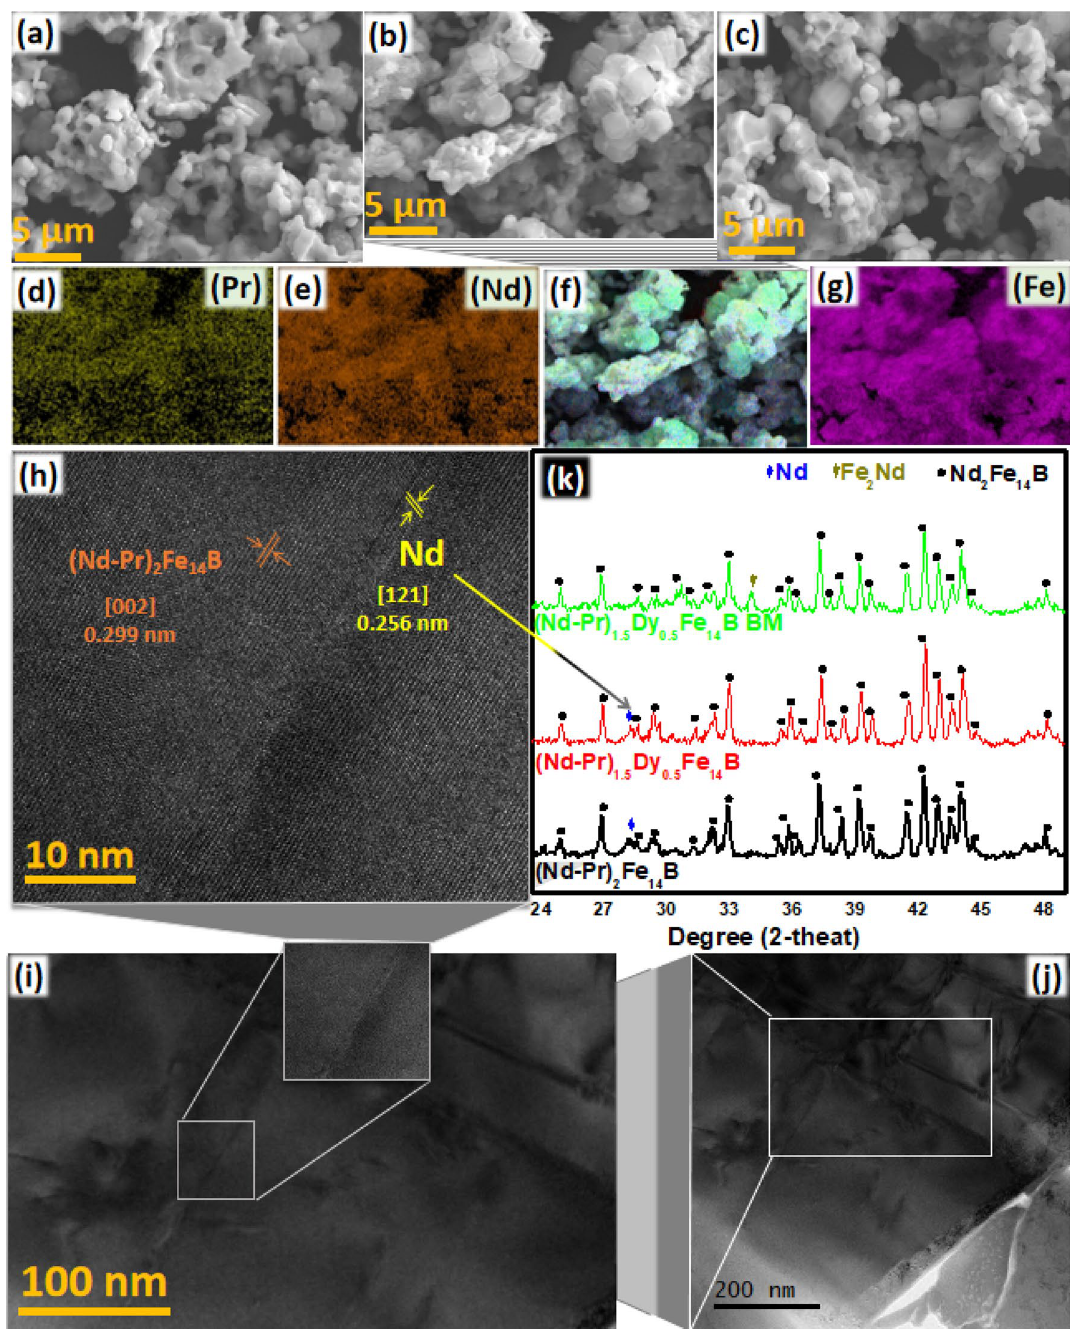
Figure 3. SEM images of ( a ) (Nd–Pr) 1.5 Dy 0.5 Fe 14 B (b) (Nd–Pr) 2 Fe 14 B ( c ) (Nd–Pr) 1.5 Dy 0.5 Fe 14 B (BM). ( d – g ) SEM–EDS of images of